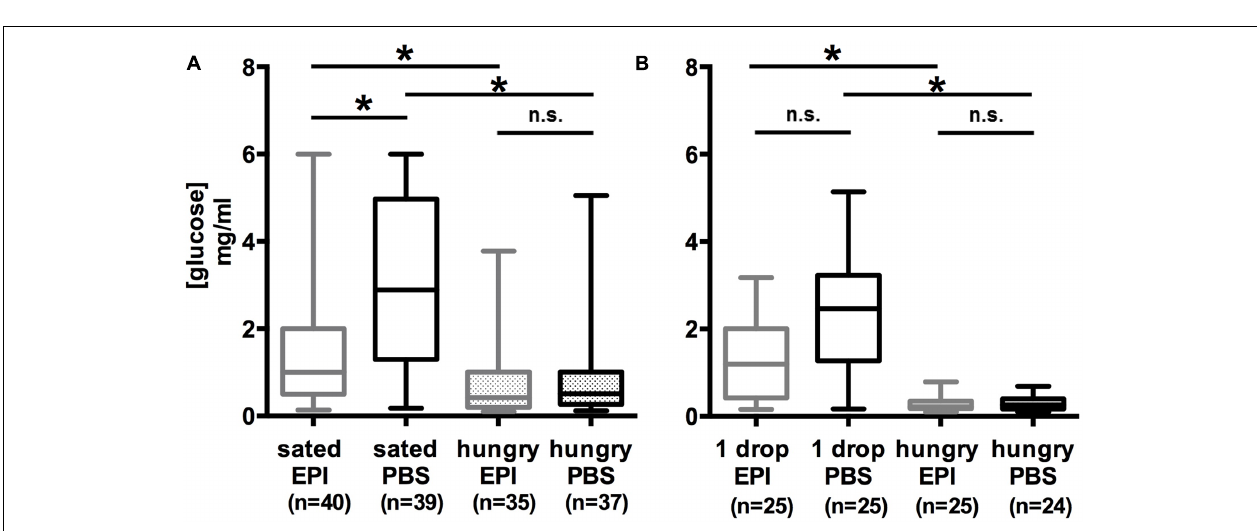
FIGURE 3 | Low hemolymph glucose concentration in honeybees following epinastine treatment depends on the feeding state. (A) The hemolymph glucose level of bees fed with 30% (w/v) sucrose solution (0.88 M) to satiation (sated PBS) was higher than that of hungry bees that remained unfed (hungry PBS). Sated and epinastine-treated bees showed a lower hemolymph glucose concentration than sated control animals (sated EPI vs. sated PBS). Epinastine-treatment did not affect hungry bees (hungry EPI vs. hungry PBS). (B) The glucose level in the hemolymph of bees fed with 4 µ l 30% (w/v) sucrose solution (0.88 M) (1 drop PBS) was higher than that of hungry bees (hungry PBS). Epinastine-treatment did not affect bees fed with 4 µ l 30% (w/v) sucrose solution (0.88 M) (1 drop EPI vs. 1 drop PBS) and hungry bees (hungry EPI vs. hungry PBS). ∗ p < 0.05. Number of bees appears in brackets.